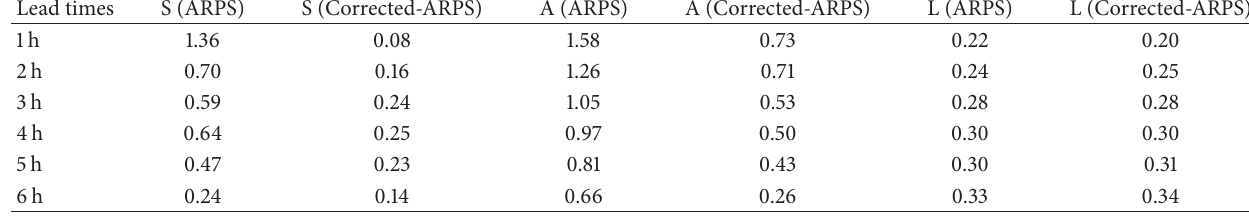
Table 2: Mean values of S-component, A-component, and L-component of the original and corrected ARPS over three heavy rain events. Lead times